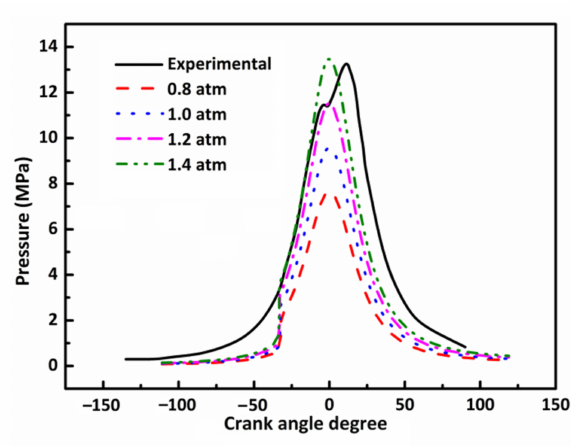
Figure 5. Comparison of different initial pressures and experimental pressure.